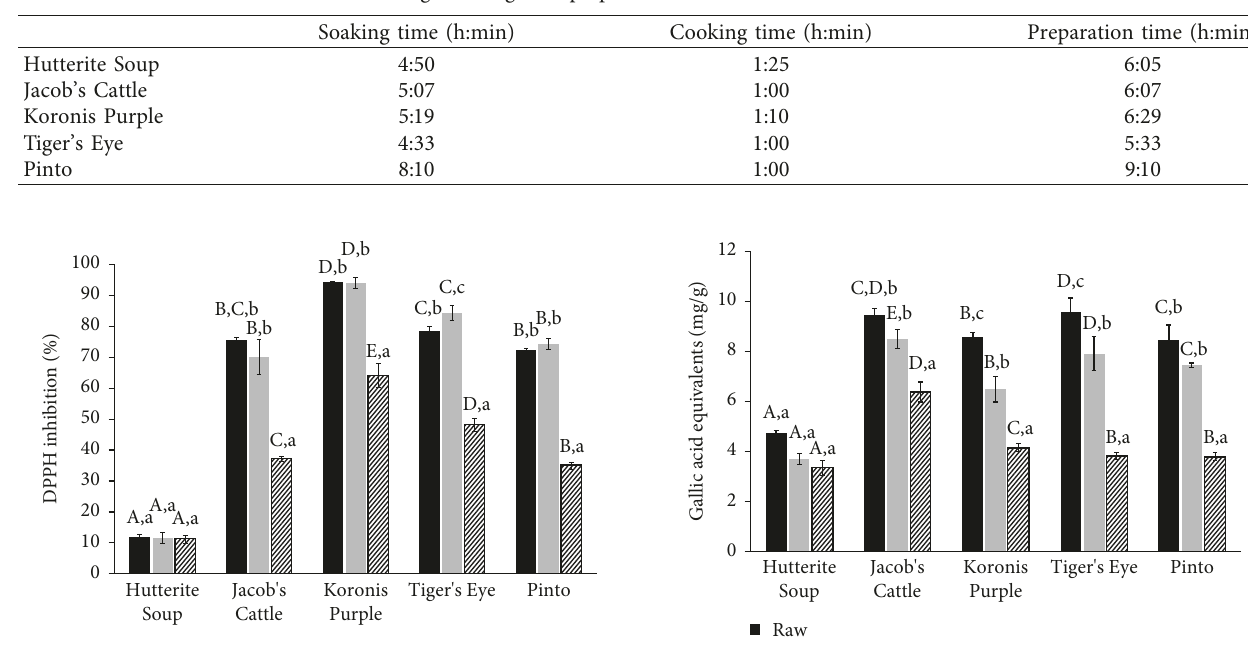
Table 1: Soaking, cooking, and preparation time for heirloom beans and Pinto.